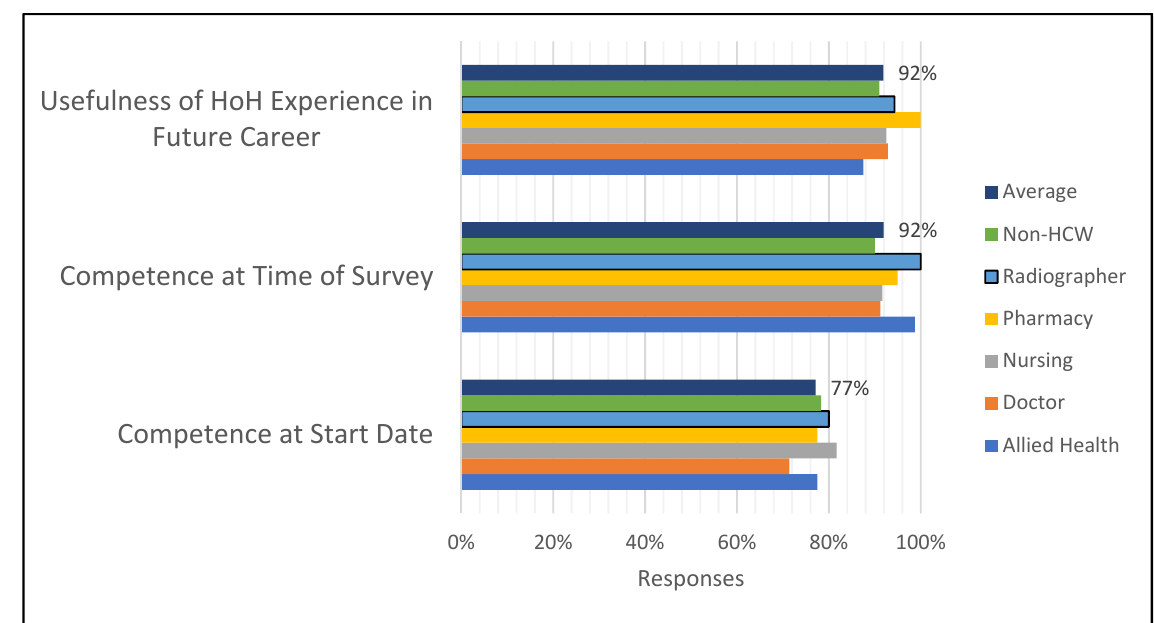
Figure 3. Reported professional development of sta ff .